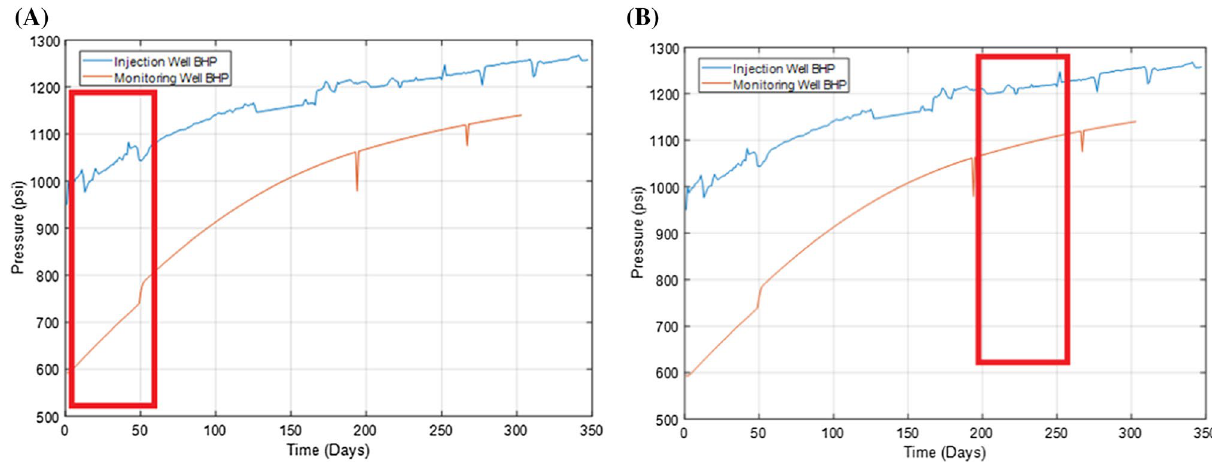
Fig. 10 Selected time intervals to estimate injectivity index for south lobe ( a ) at early time interval and ( b ) at later time